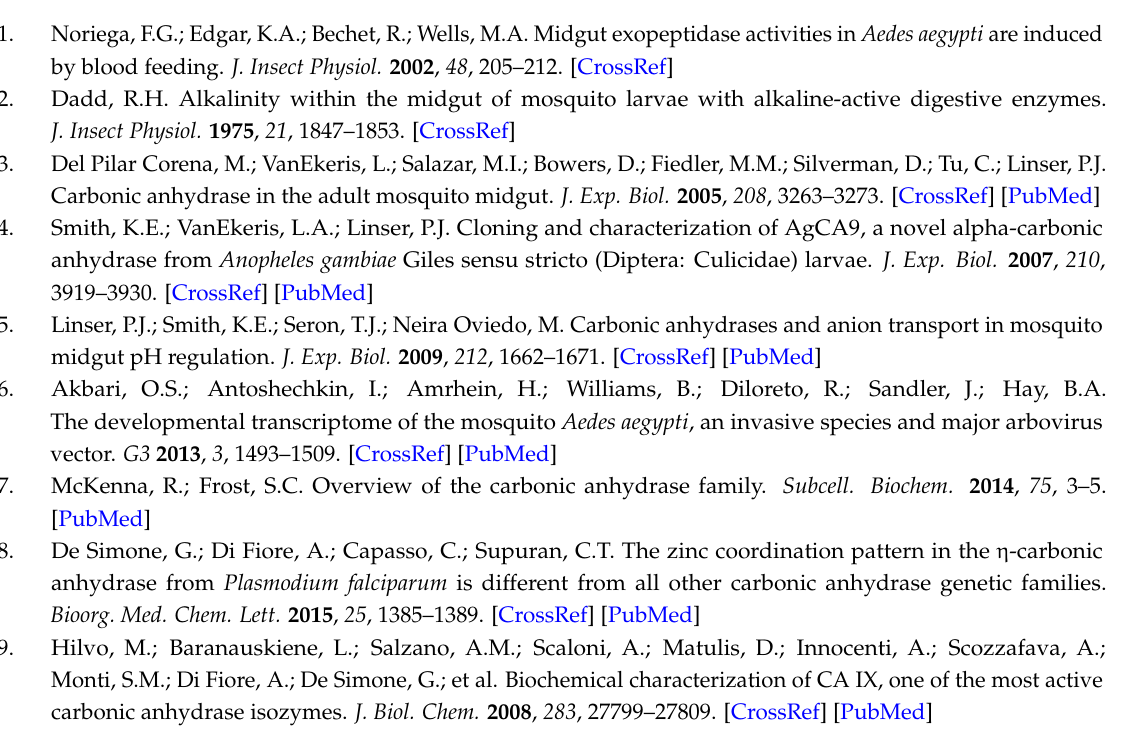
Figure S1: Alignment of AeCA3 splice variants, Figure S2: Alignmnet of AeCA7 splice variants. Acknowledgments: Funding was provided by the University of Florida and NIH NIAID RO1AI 5098-8 to PJL. Author Contributions: Daniel P. Dixon performed the bulk of the analyses reported herein. Leslie Van Ekeris performed technical support in all aspects of microscopy. Paul J. Linser oversaw the research and contributed to the writing of the